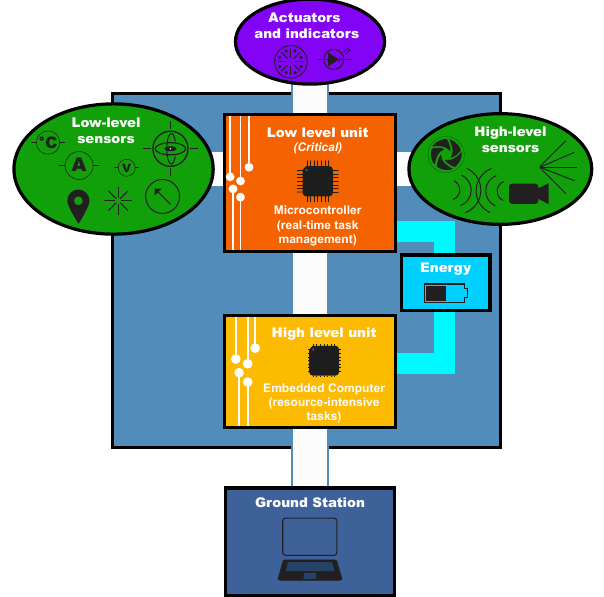
Figure 1. General organization of an exploration robot, whatever its environment of evolution (air, land, sea), with the low-level critical architecture and the high level resource-intensive